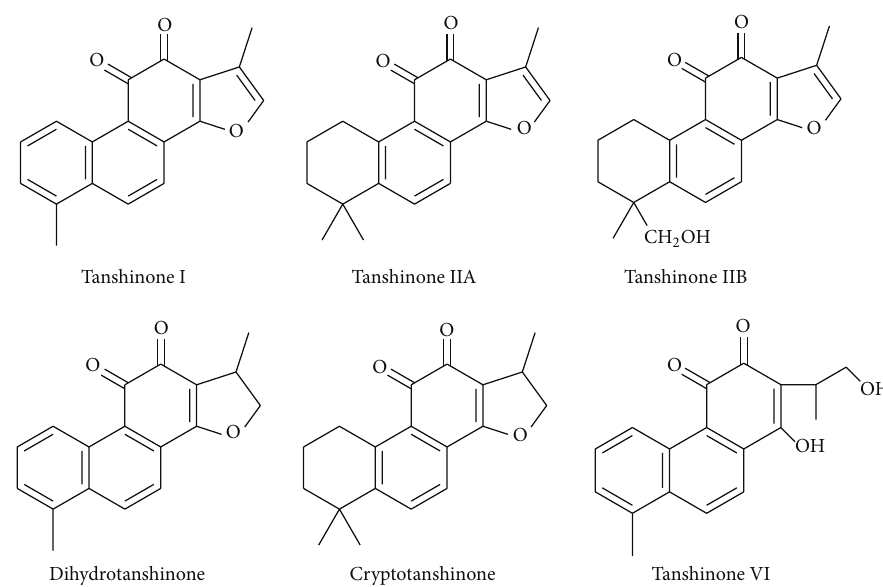
Figure 1: Chemical structures of major